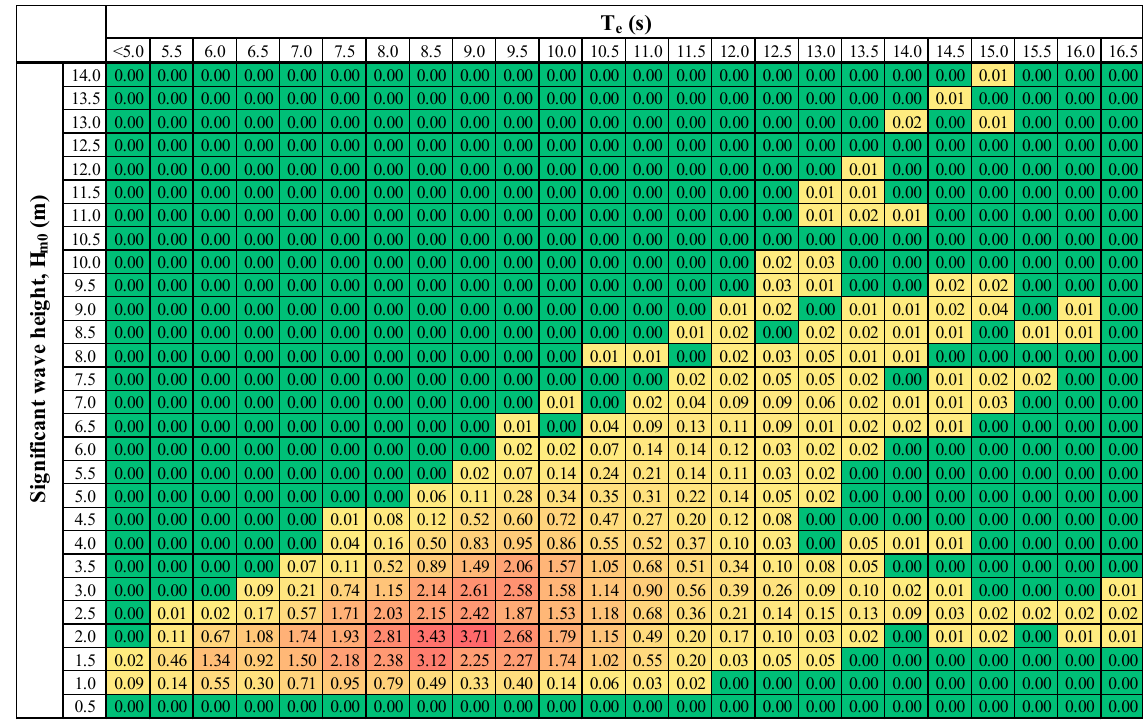
Figure 9. Scatter diagram of the waves in AMETS in 2010 (available data points 13189 for two wave buoys, 75% availability).